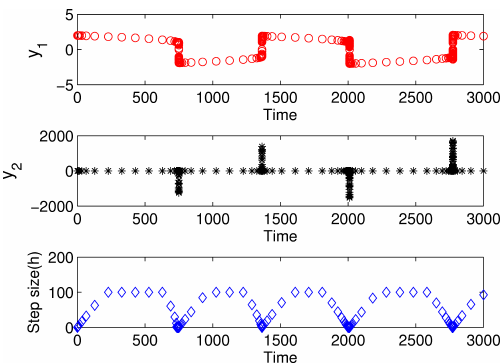
Fig. 4. Comparison of corresponding time step size for proposed scheme and existing method (ode15s)